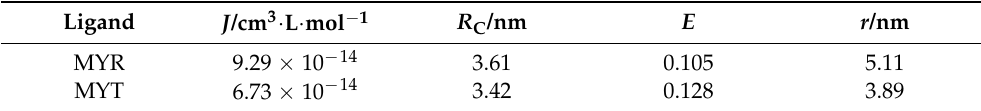
Figure 5. The normalized emission and absorption spectra of the two FRET pairs with schematized spectral overlaps are shown. ( A ) PK (black, donor) and MYR (blue, acceptor), ( B ) PK (black, donor) and MYT (red, acceptor). The concentrations of PK, MYR and MYT are 3.46 µ M. Table 3. Calculated spectral overlap integral ( J ), critical distance ( R C ), energy transfer efficiency ( E ) and binding distance ( r ) for PK and different ligands.